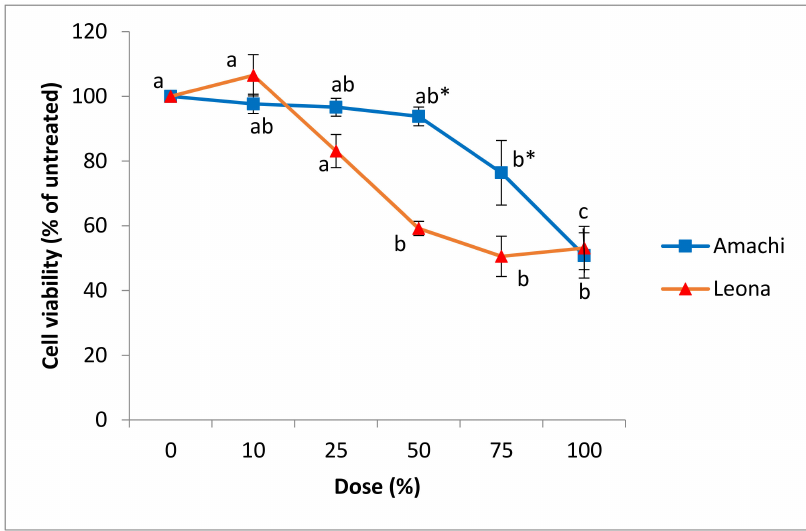
Figure 4. Effect of in vitro digests of cvs. Amachi and Leona on the viability of Caco-2 cells as assessed via the the 3-(4,5-dimethylthiazol-2-yl)-2,5-diphenyl tetrazolium bromide (MTT) assay. Values are means ± SE of four independent experiments. Means within cultivar treatment without a common letter are significantly different ( p < 0.05). The symbol * represents the comparison between cvs. Amachi and Leona at a specific digest dose as significantly different ( p <